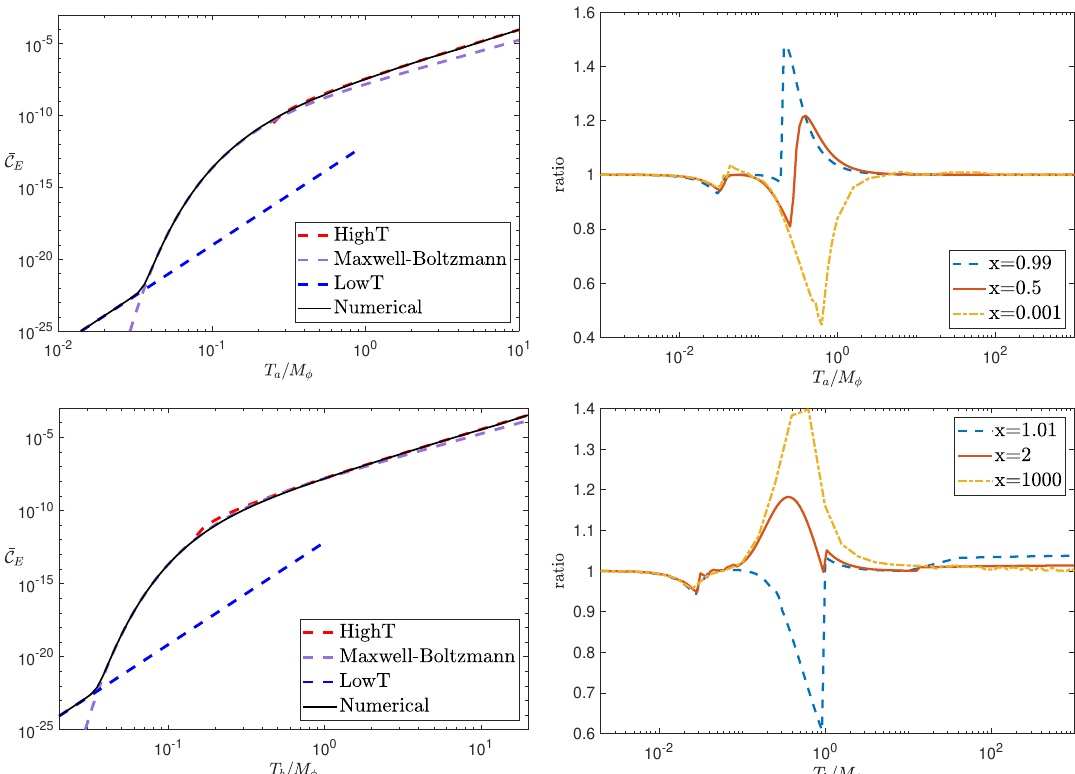
Figure 17. Left Panel: magnitude of total energy transfer collision term (cid:22) C E = abs( C E ) =M 5 function of T = max( T a ; T b ) at (cid:12)xed temperature ratio x = T b =T a = 0 : 5 (top left) and x = 2 (bottom left). The collision term is always positive for the top left panel and always negative for the bottom left. The black solid line corresponds to C numerically evaluated using eq. (C.12), the red dashed line corresponds to C high-T (eq. (C.55)), the purple dashed line corresponds to C MB (eq. (C.57)) and the blue dashed line corresponds to C low-T (eq. (C.58)). Right Panel: ratio of the analytic approximation to C E (eq. (C.59)) to the full numerical value as a function of T = max( T a ; T b ) for (cid:12)xed temperature ratios T b =T a = x = 0 : 99 ; 0 : 5 ; 0 : 001 (top right) and x = 1 : 01 ; 1 ; 1000 (bottom right). Results are shown for (cid:22) a = 0 : 01 M (cid:30) , 2 y b M (cid:30) =(cid:22) a = 0 : 5, and m a;b = 10 (cid:0) 8 M (cid:30)